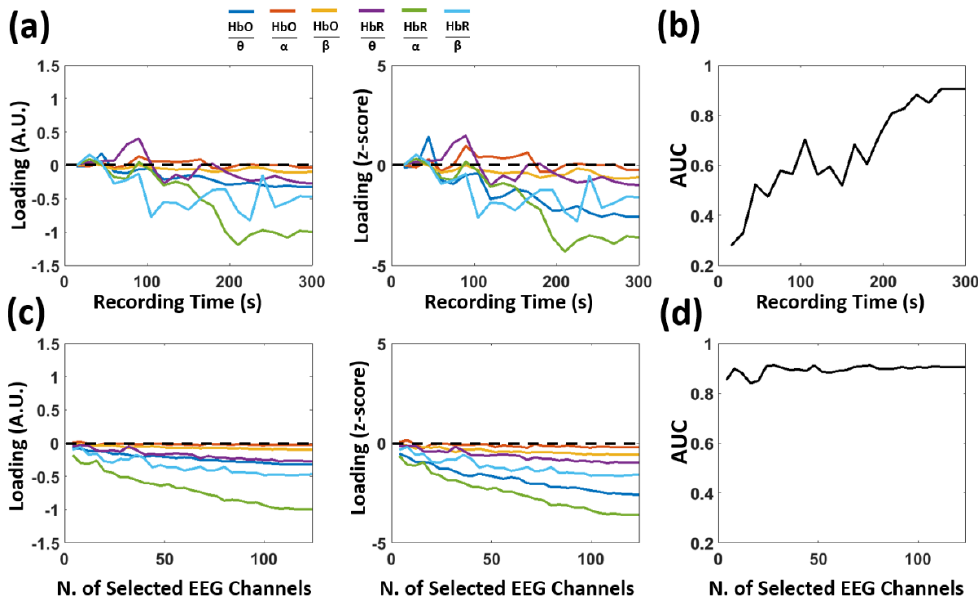
Figure 9. Cross-validated (CV) loadings and classification performance of the multivariate data-driven analysis predicting AD and HC from the 6 NC metrics as a function of either recording time or number of EEG channels employed. ( a ) Left panel: loadings as a function of recording time; right panel: z-scores, obtained as loadings normalized by their standard deviation (estimated using bootstrapping), as a function of recording time. ( b ) Area under the curve (AUC) of the ROC analysis as a function of recording time. ( c ) Left panel: loadings as a function of the number of randomly selected EEG channels; right panel: z-scores, obtained as loadings normalized by their standard deviation, as a function of the number of randomly selected EEG channels. ( d ) AUC of the ROC analysis as a function of the number of randomly selected EEG channels.